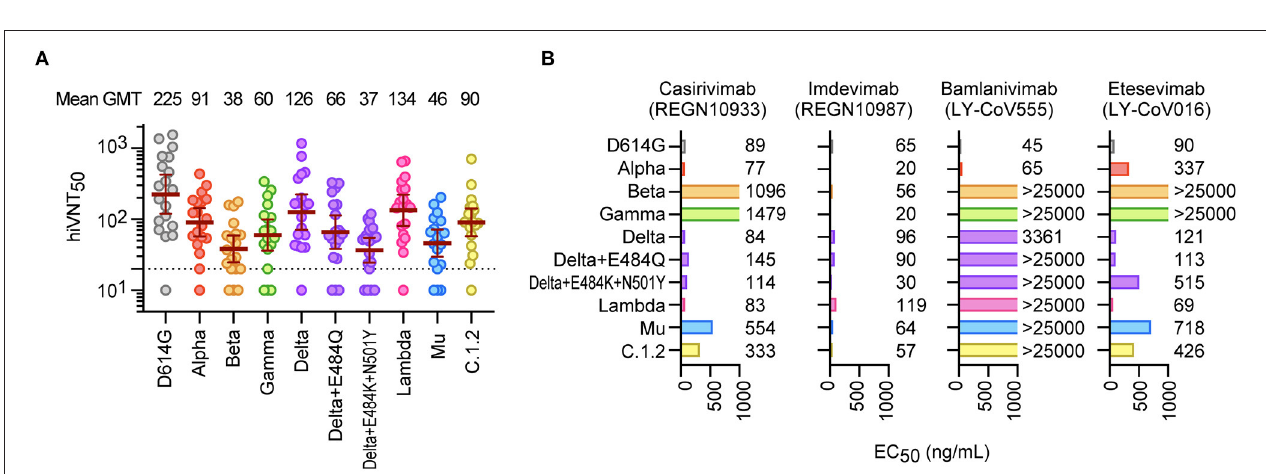
FIGURE 2 | Neutralization of SARS-CoV-2 variants by mRNA vaccine sera and therapeutic antibodies. (A) Neutralizing activity of Pvac19 sera panel ( n = 19, 1 week after the second dose) against each variant. Serum dilutions showing 50% inhibition of infection (hiVNT 50 ) were determined via a quantitative hiVNT. The dotted line indicates the cut-off threshold of this assay (hiVNT 50 = 20). The mean of two independent determinations is plotted. The brown lines indicate the geometric mean titers (GMT) ± 95% confidence intervals, the values of which are displayed above the graph. (B) Neutralization of each mutant strain by two dual antibody cocktails [REGN-CoV2; REGN10933 (Casirivimab) and REGN10987 (Imdevimab), and LY-COV; LY-CoV555 (Bamlanivimab) and LY-CoV016 (Etesevimab)]. The numbers indicate the 50% effective concentration (EC 50 , ng/mL), determined by two independent experiments. Since these nAbs are treated as a cocktail, they are considered effective if the EC 50 of either antibody is equivalent to or lower than that of the D614G